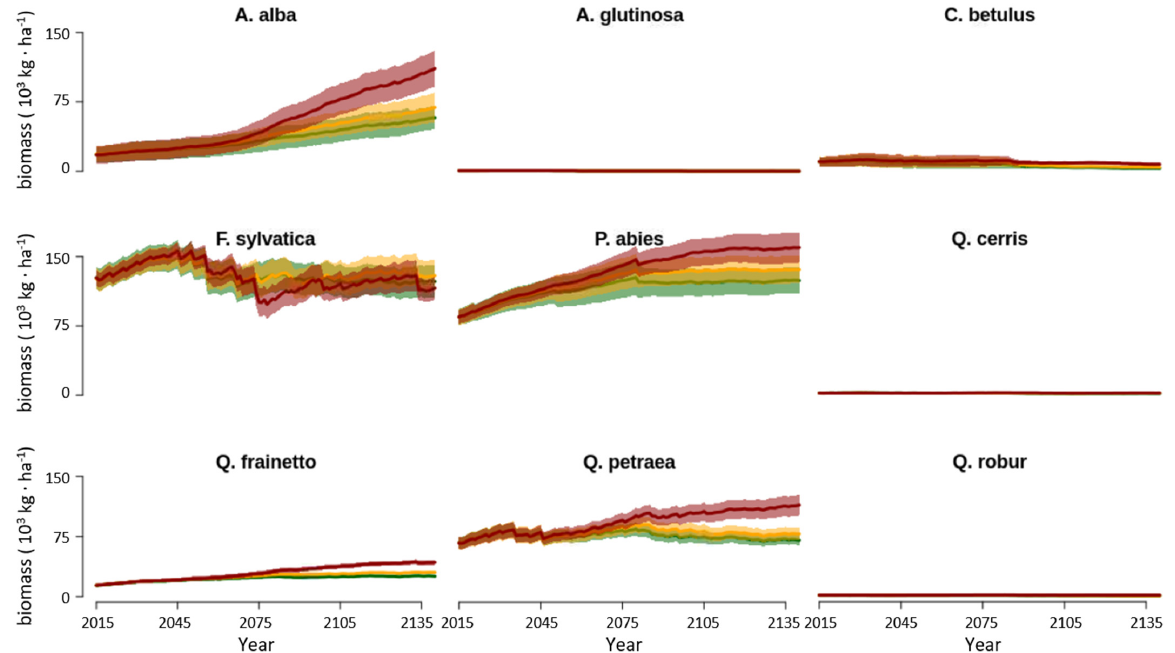
Figure 6. Mean (dashed line) and 95% confidence interval (shaded area) of the species living biomass ( · 10 3 kg · ha − 1 ) measured over time under the three climate change scenarios: RCP 2.6 (green), RCP 4.5 (orange) and RCP 4.5